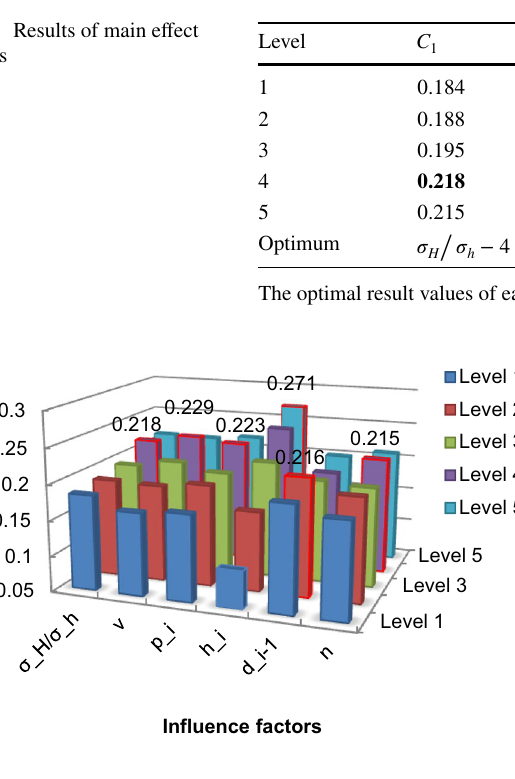
Fig. 10 Main effect analysis results of each level in each factor in 3D